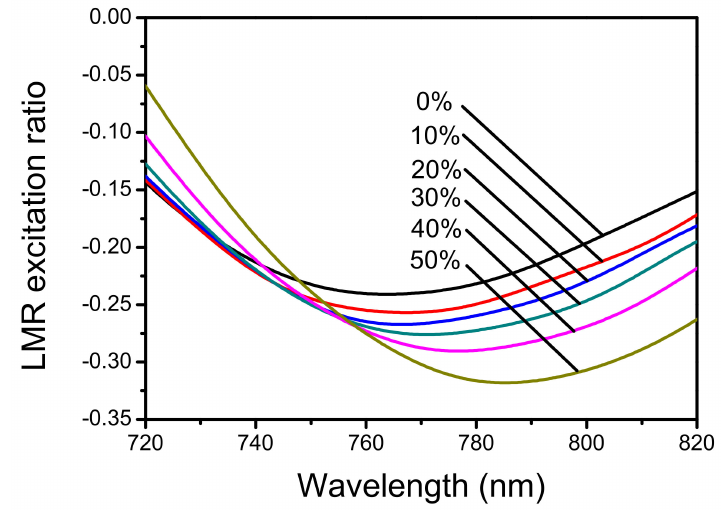
Figure 5. Spectral response of the LMR excitation ratio with the bared LMROPW for the concentration of the glucose solution from 0% to